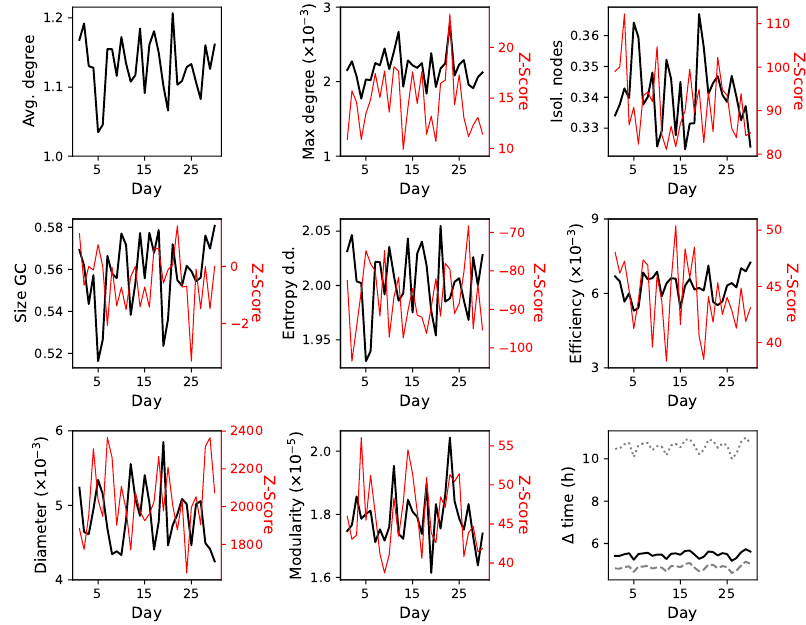
Figure A10. Properties of the interaction networks for executed trajectories, corresponding to Septem- ber 2015. Each panel depicts the evolution through time of a topological metric, as defined in Section 2; black (left Y axes) and red lines (right Y axes), respectively, correspond to the raw values and their Z-Scores. In the last panel, the black line corresponds to the median, the gray dashed one to the mean, and the gray dotted one to the